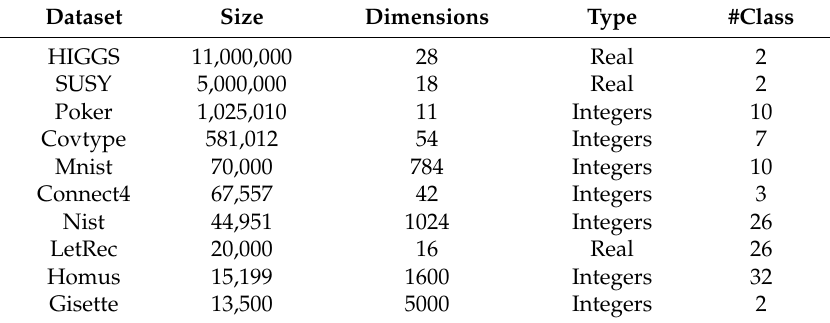
Table 2. Description of datasets used for evaluation and comparison of the proposed